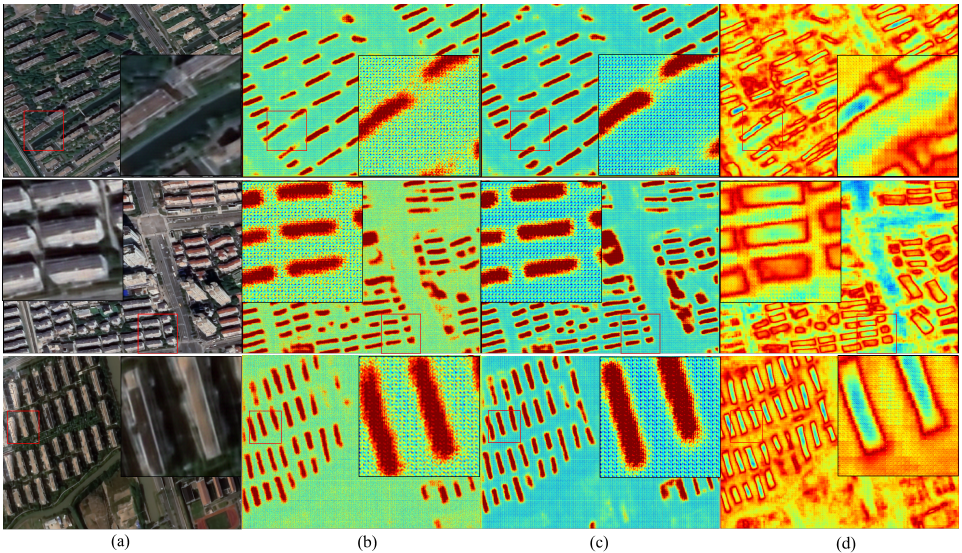
Figure 7. The visualizations of the penultimate CNN layer (better visualized in color). ( a ) is the input remote sensing images; ( b ) is the visualization results of DlinkNet; ( c ) is the visualization results of DES; ( d ) is the variance between ( b , c ), which denotes the information enhanced in the segmentation